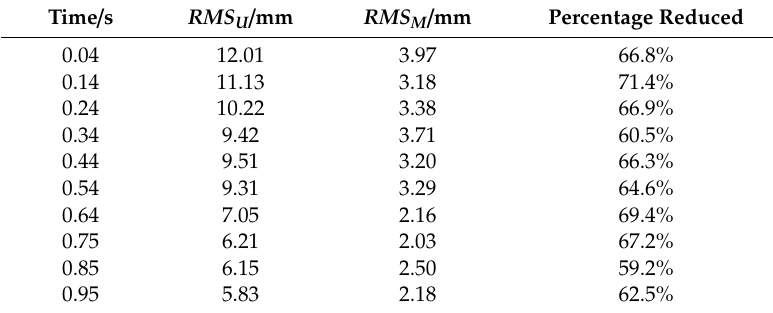
Table 5. Comparison of deformation along the y -axis for di ff erent time, RMS U and RMS M are, respectively, the accuracy of the deformation computed form the unmodified and modified strain measurements with